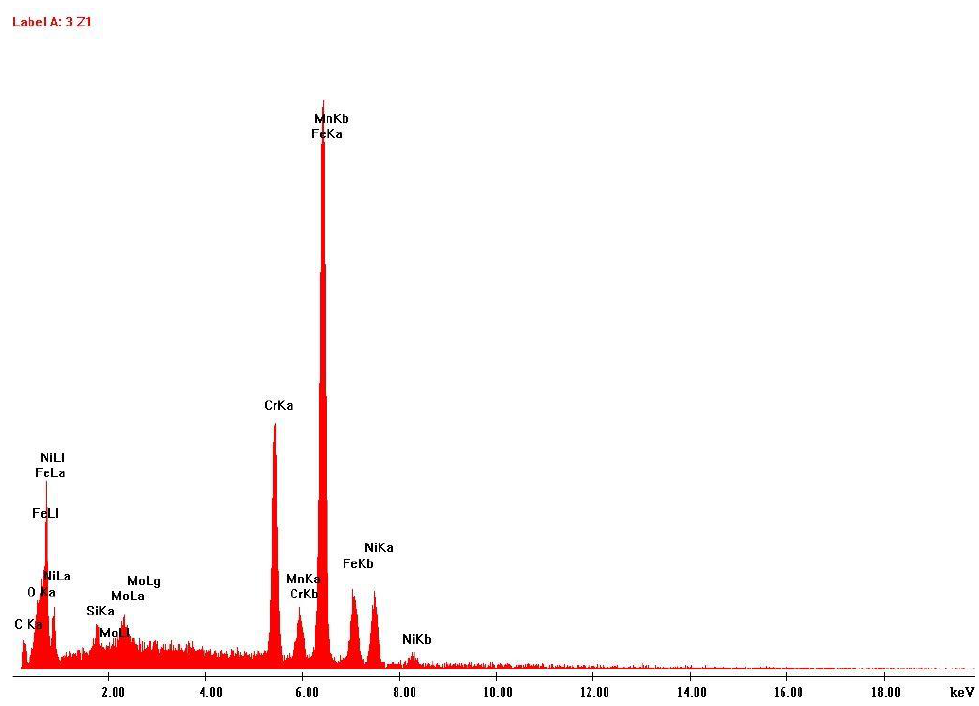
Figure 4. EDS analysis results: Stainless steel 316L raw powder, before any AM process.